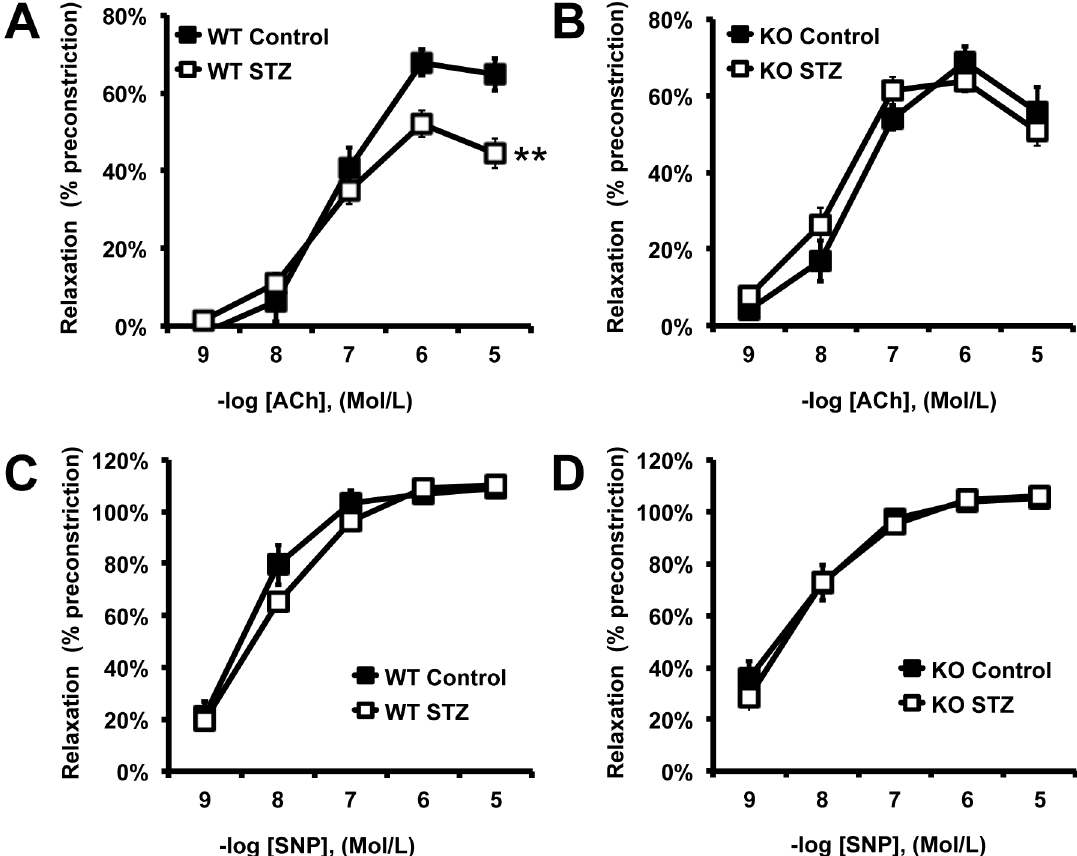
Fig 1. PTP1B deletion prevents STZ-induced endothelial dysfunction. Concentration response curves to acetylcholine (ACh, A , B )) and sodium nitroprusside (SNP, C, D ) conducted in wild-type (WT) and PTP1B KO mice (KO) treated with citrate-buffer (control) or streptozotocin (STZ). Data are mean ± SEM, n = 6 per group, ** p < 0.001 vs .